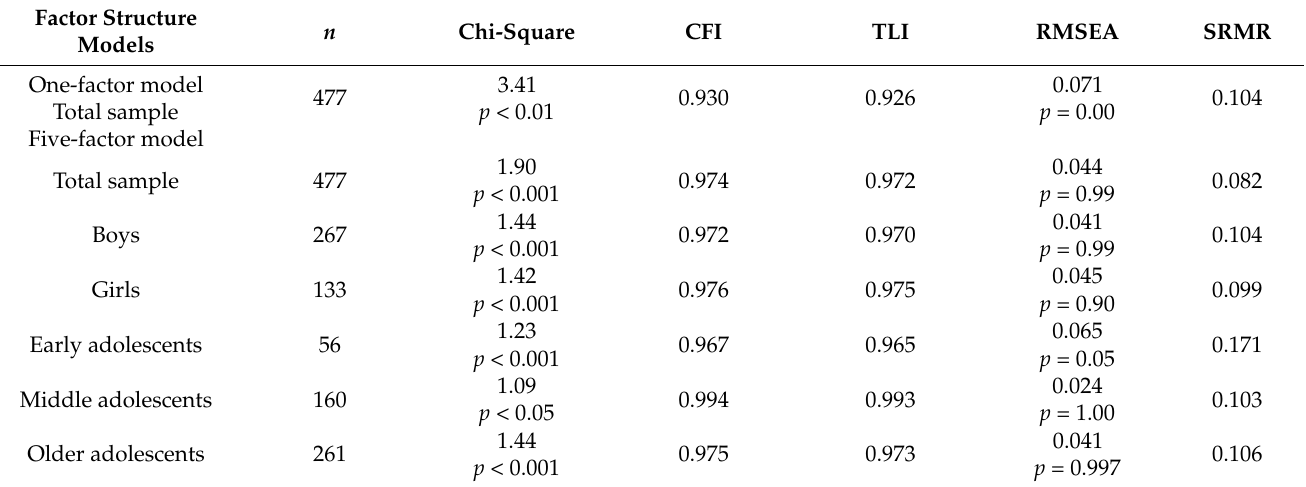
Table 3. Model fit indices for the one-factor model and the five-factor models of the Romanian version of the SCARED (n = 477).